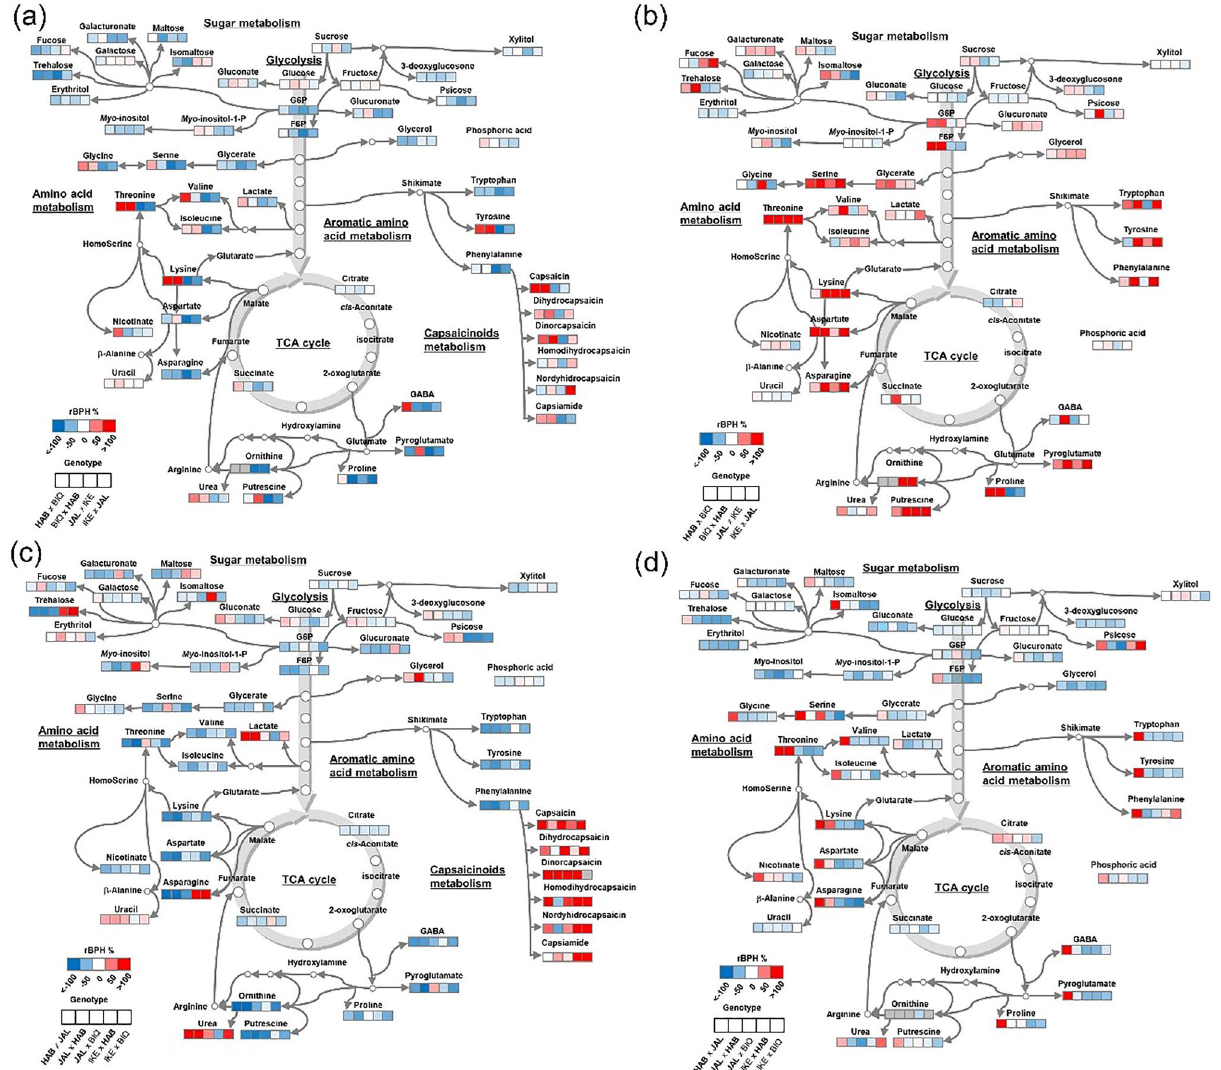
Figure 3. Heat map of primary metabolites and capsaicinoids in the fruit placenta ( a ) and pericarp ( b ) of intra- specific and ( c ) placenta and ( d ) pericarp or interspecific hybrids of C. chinense cv. Habanero (HAB), C. chinense cv. Biquinho (BIQ), C. annuum cv. Jalapeño (JAL) and C. annuum cv. Cascadura Ikeda (IKE). The pungent genotypes are shown in boldface. Each square represents a genotype (n = 7). The color key indicates the relative best parent heterosis (BPH) value (red = higher, blue = lower). The maps were generated using a custom-made template on MS-Powerpoint by color-coding the results obtained from Metaboanalyst 5.0 (https:// www. metab oanal yst. ca/) and the heterosis calculations described in the “Materials and methods”